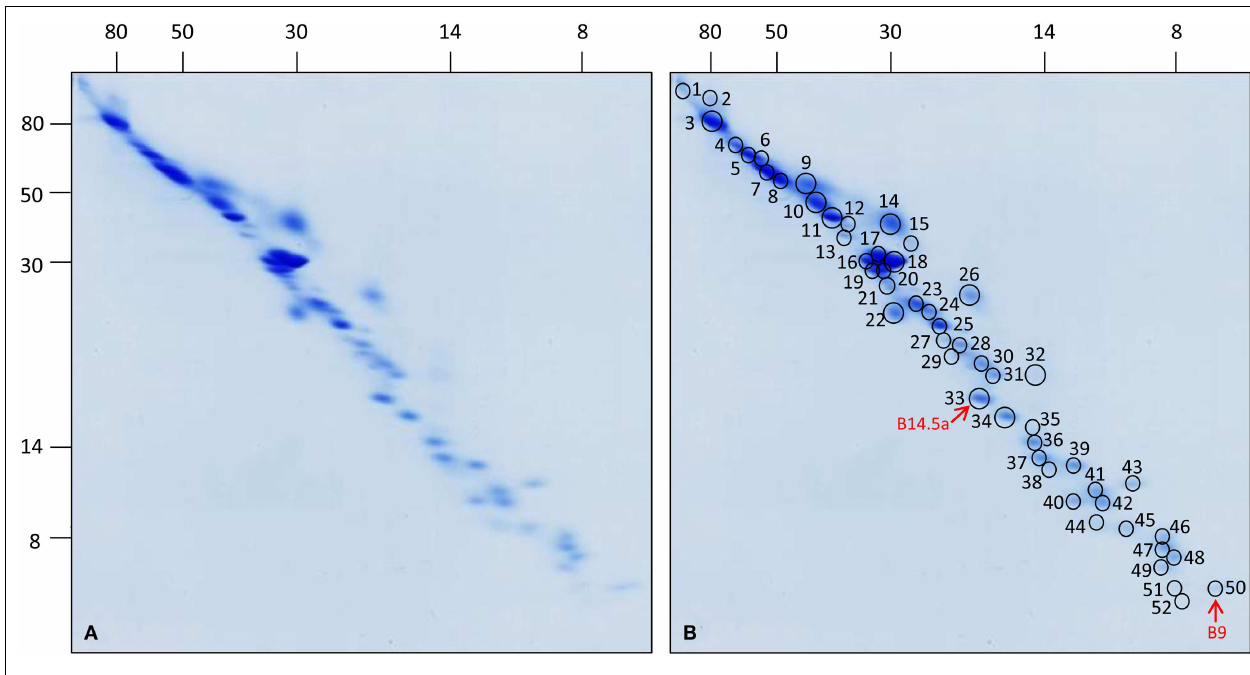
spectrometry. Numbers correspond to those given in Table 1 . Red arrows indicate the newly identified subunits B14.5a and B9. Molecular masses (in kilodaltons) are given to the left and on the top of the